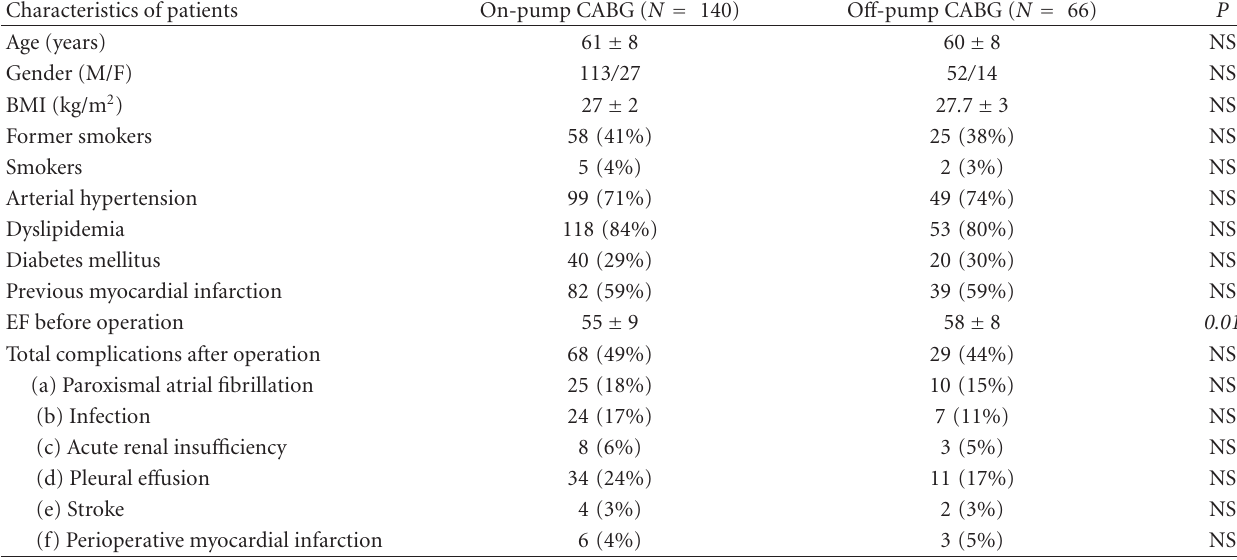
Table 1: Di ff erences in basic characteristics: on-pump versus o ff -pump CABG patients. Characteristics of patients